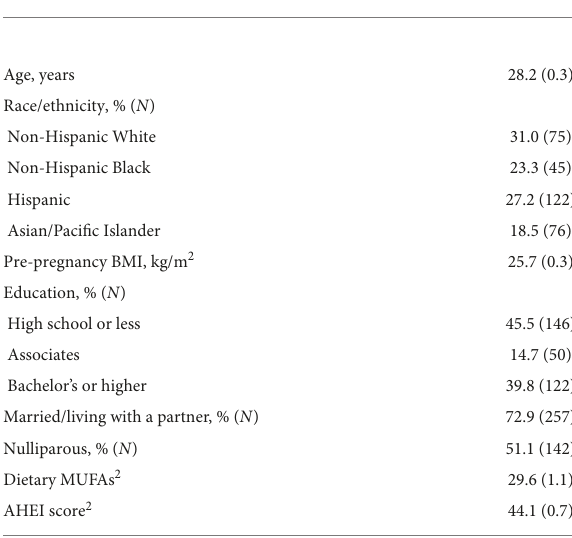
TABLE 1 Baseline characteristics of the analytical population from the NICHD Fetal Growth Studies-Singleton Cohort.